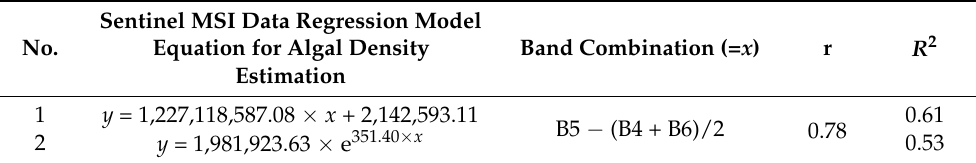
Table 9. Regression model for the retrieval of algal density concentration using Sentinel MSI training